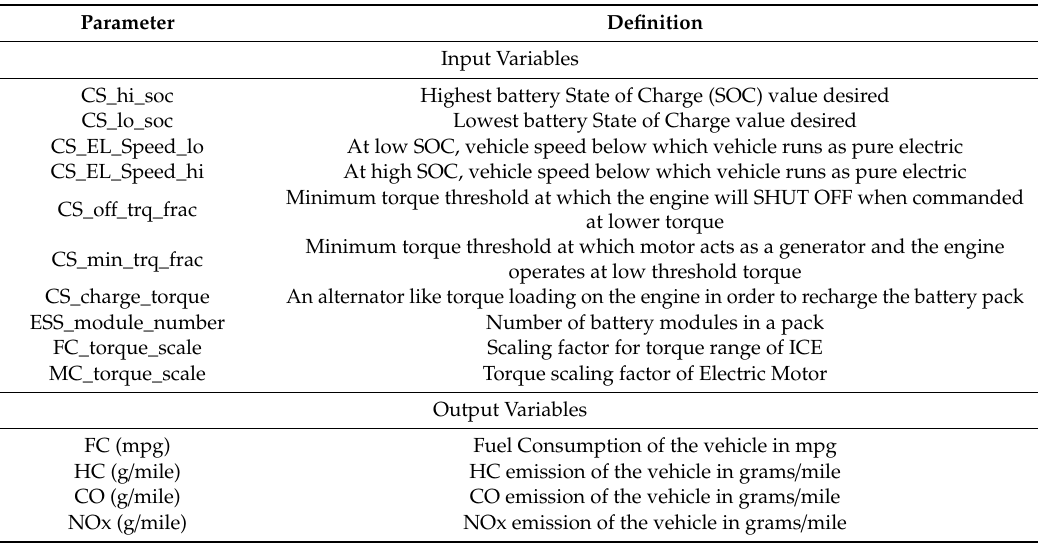
Table 2. Optimization Parameter